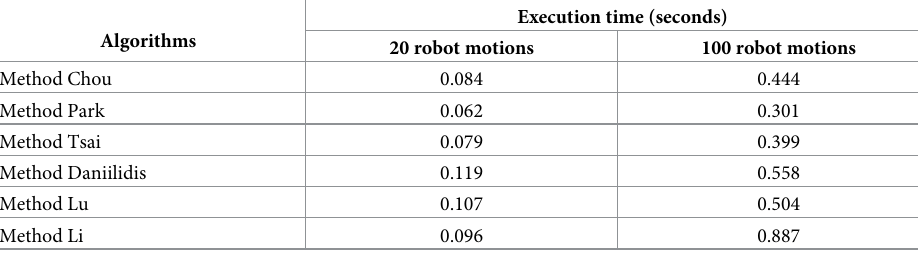
Table 1. Comparison of algorithm execution time for 20 and 100 robot